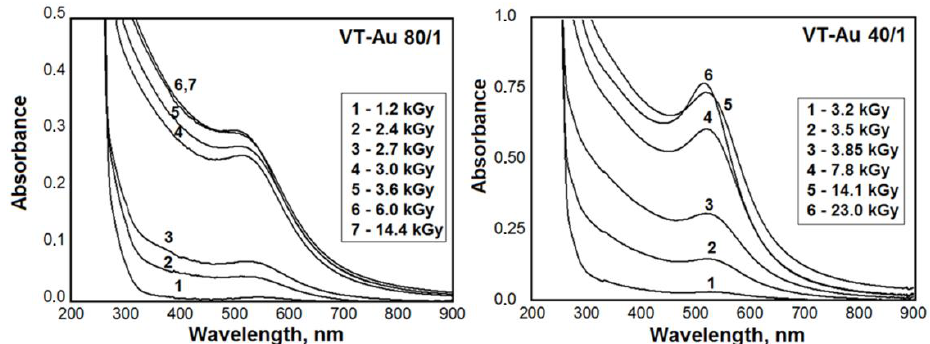
Figure 3. The UV-Vis spectra of irradiated 1 wt.% VT solutions containing Au(III) ions at the ratios (VT)/(Au(III)) of 80/1 and 40/1.